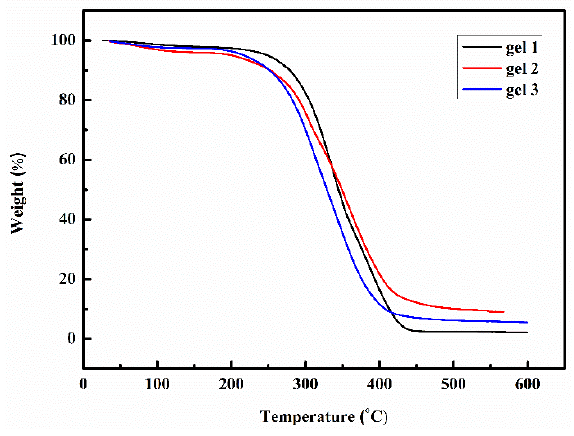
Figure 5. TGA curves of hydrogels.